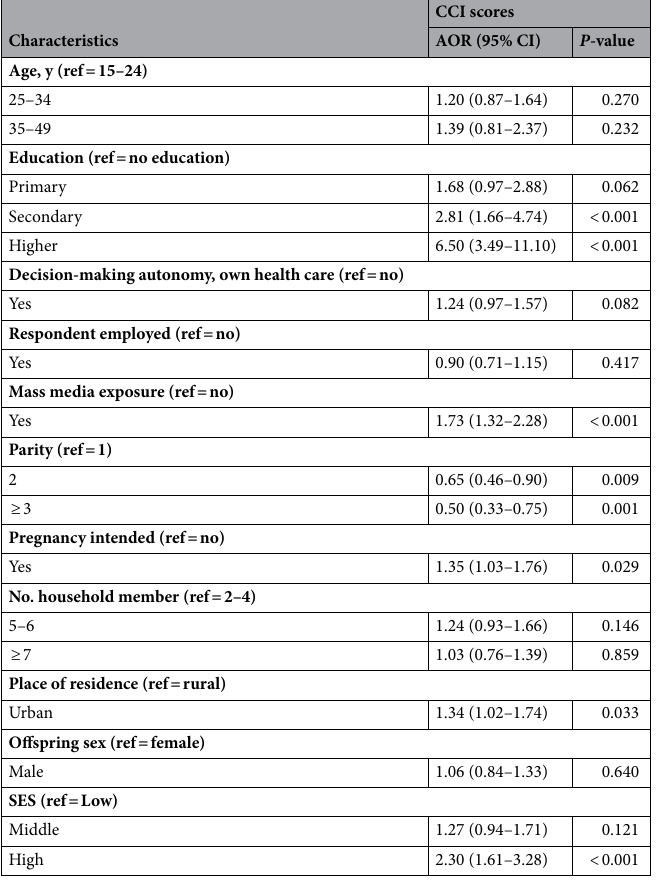
Table 4. Ordinal logistic regression models for the association between SES and CoC across the women’s reproductive life cycle and other covariates: Bangladesh Demographic and Health Survey 2017–18 (n = 1527). CI = confidence interval; AOR = adjusted odds